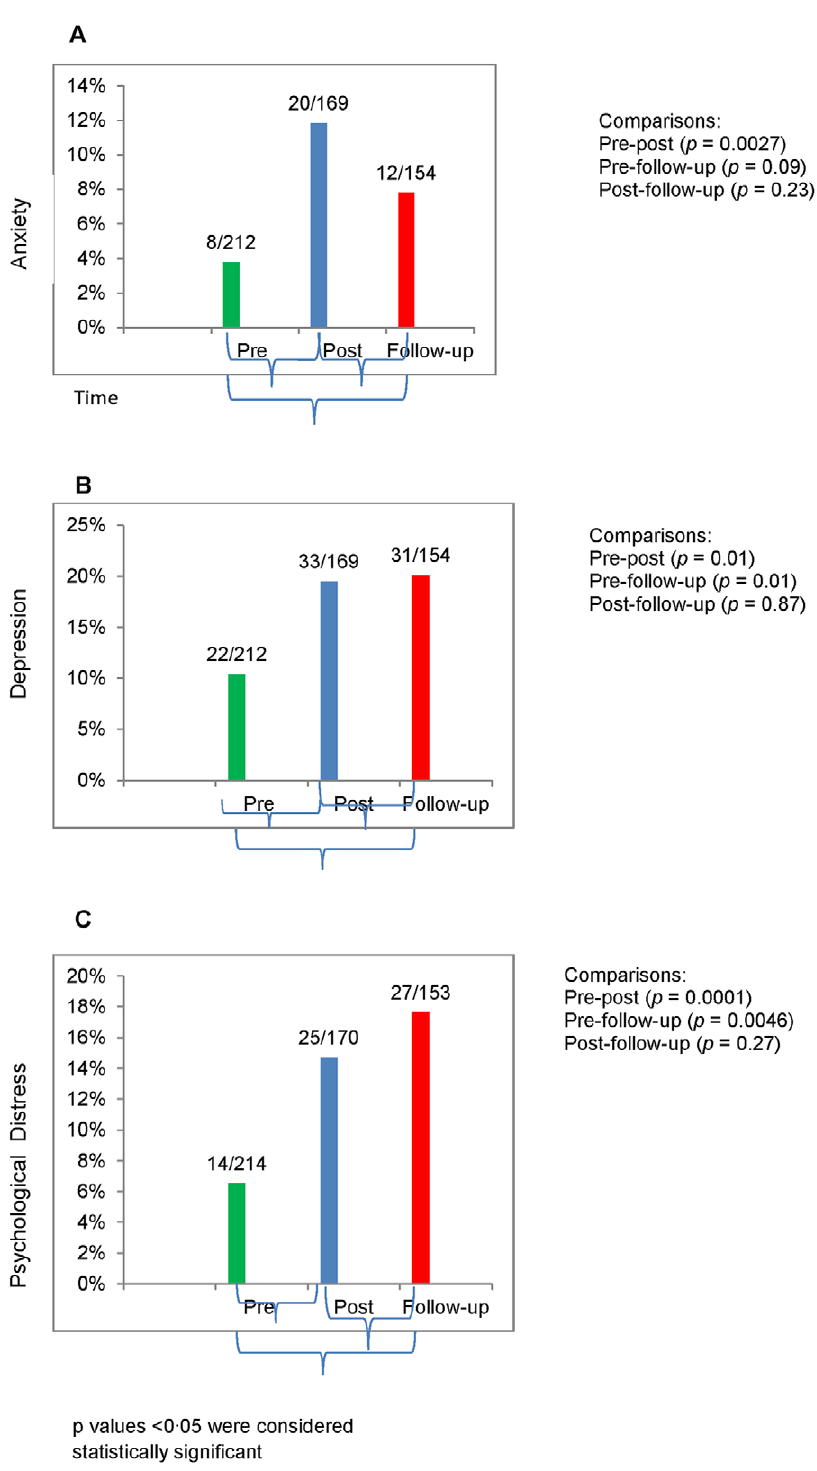
Figure 1. Mental Health Outcomes. Mental health outcomes at pre-deployment (N=212), post-deployment (N=169), and follow-up (N=154) 3– 6 months after returning from assignment.